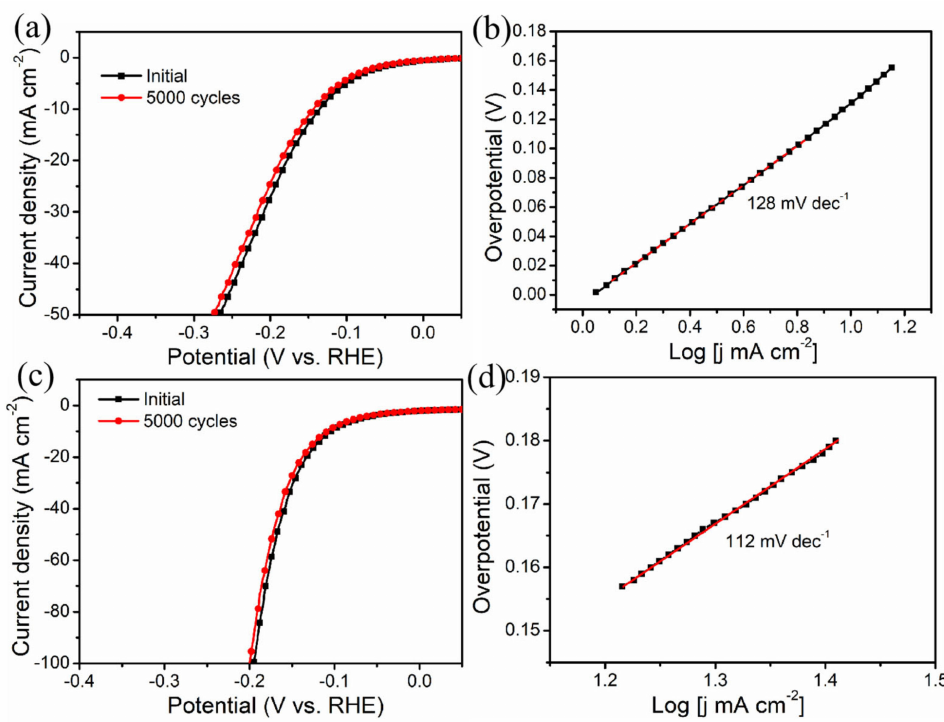
Figure 5. LSV curves of the Ni-CoP 3 -7 NWAs/CC in ( a ) 1.0 M PBS (pH 7) and ( c ) 1.0 M KOH (pH 14), and the corresponding Tafel plots in ( b , d